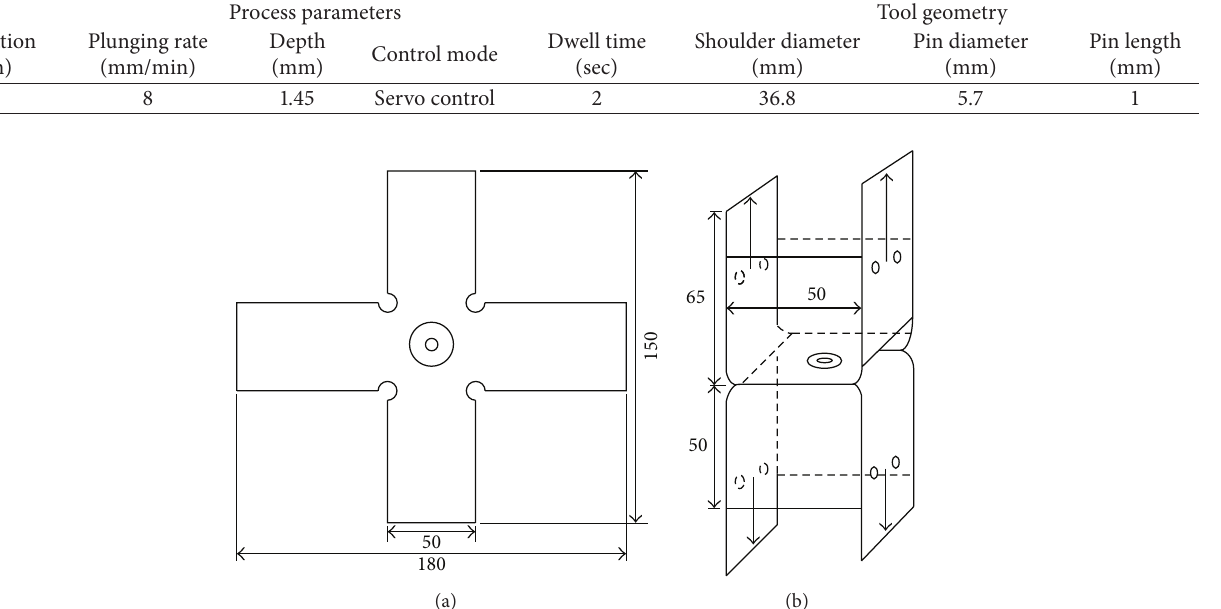
Figure 1: Schematics of fabricated and welded specimens: (a) top view of unfolded square-cup specimen and (b) folded square-cup specimen with FSSW (dimensions in mm).